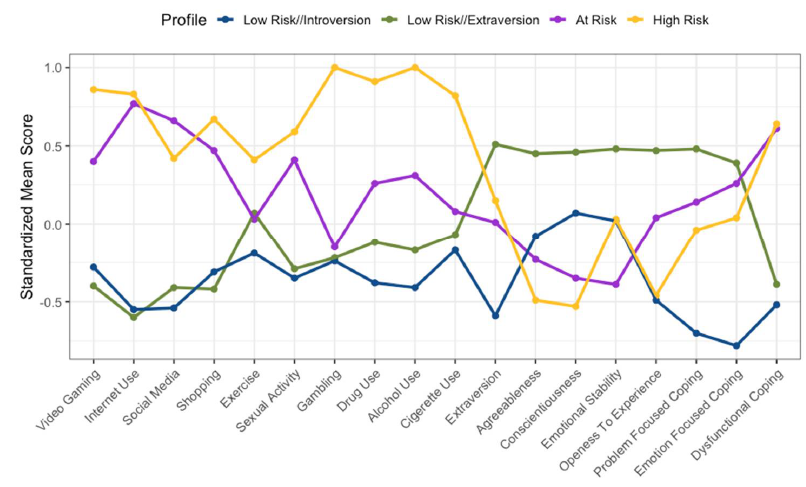
Figure 1. Standardized mean score graph of the UK cohort.